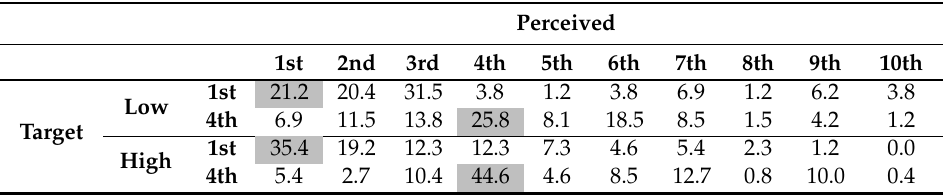
Table 3. Confusion matrix of corrective focus perception (percentage values) by position in the digit strings. Numbers highlighted in gray indicate correct identification rates. (Top panel: Low tone group, bottom panel: High tone